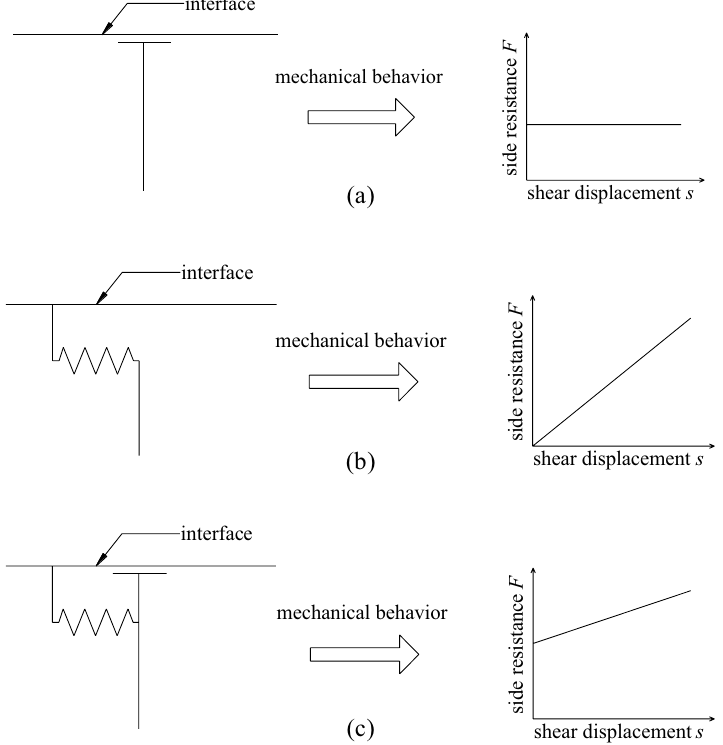
Figure 5. Models of interface coupling element. ( a ) Friction; ( b ) Mechanical interlock; ( c ) Combinatorial coupling.